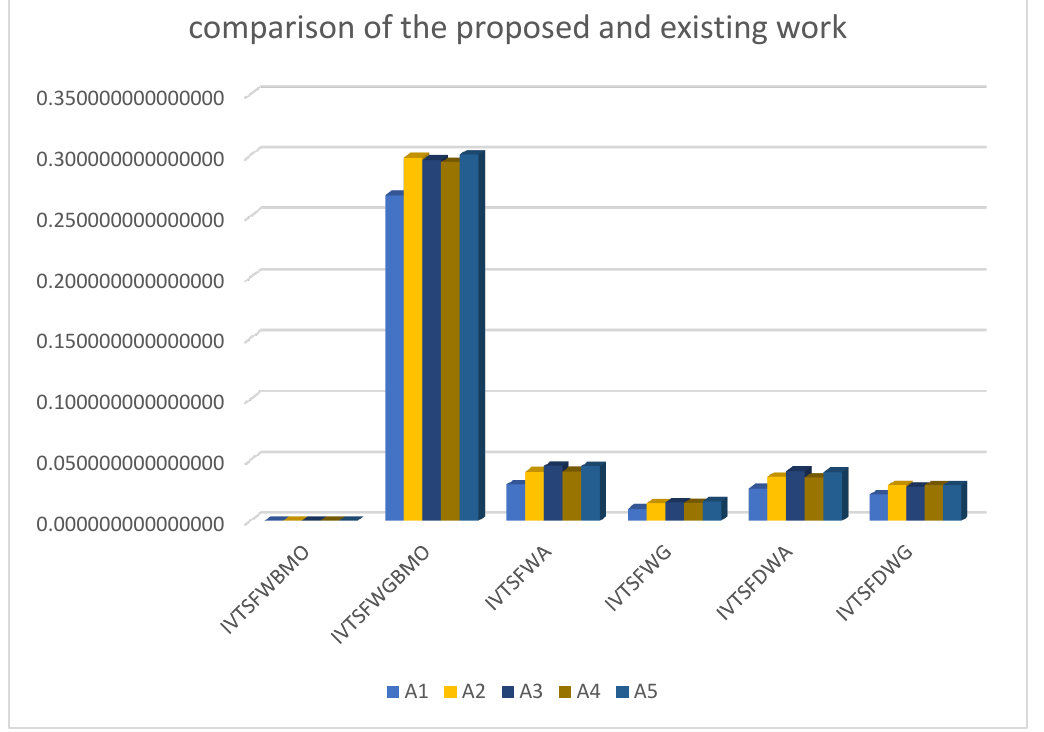
Figure 2. Illustration of the information in Table 8 .